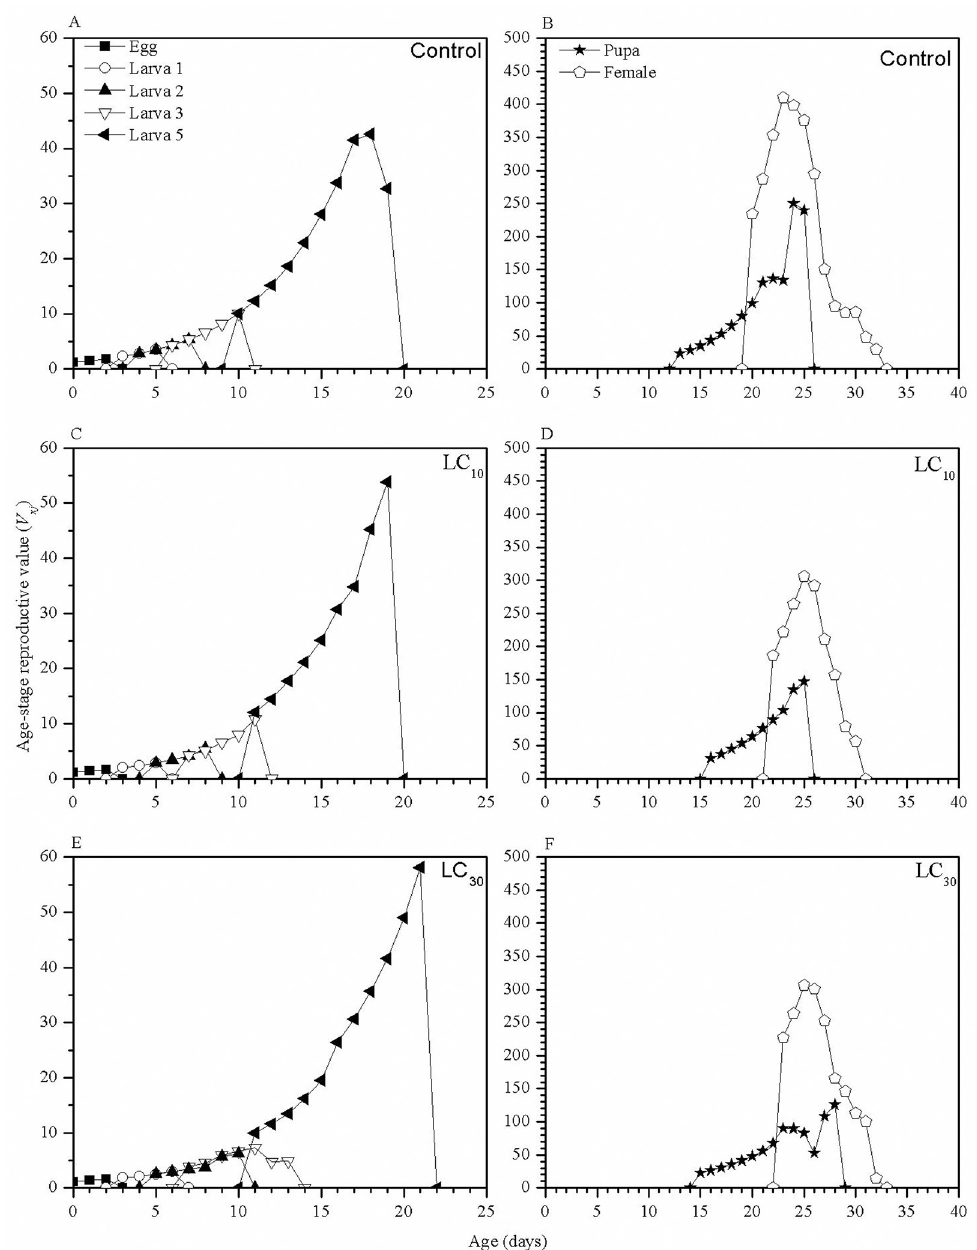
Fig 4. The age-stage reproduction curves ( V ) of S . exigua . A, the V curves of the larvae in the control group; B, the V xj xj xj curves of the pupae and adult females in the control group; C, the V xj curves of the larvae in the LC 10 group; D, the V xj curves of the pupae and adult females in the LC 10 group; E, the V of the larvae in the LC 30 group; and F, the V of the xj xj pupae and adult females in the LC 30 group. that S . exigua larvae were more sensitive to TCAP (LC , 10.371 μ g L -1 ) than to other insecti- 50 cides, such as chlorantraniliprole (LC , 35 μ g L -1 ), cyanamide (LC , 92 μ g L -1 ), chlorpyrifos 50 50 (LC , 2401 μ g L -1 ), and emamectin benzoate (LC , 537 μ g L -1 ), avermectin (LC , 2687 μ g L -1 ), 50 50 50 hexaflumuron (LC , 7384 μ g L -1 ), and methoxyfenozide (LC , 2167 μ g L -1 ) [2]. Our results 50 50 showed that the fecundity and longevity of S . exigua larvae and adults were significantly